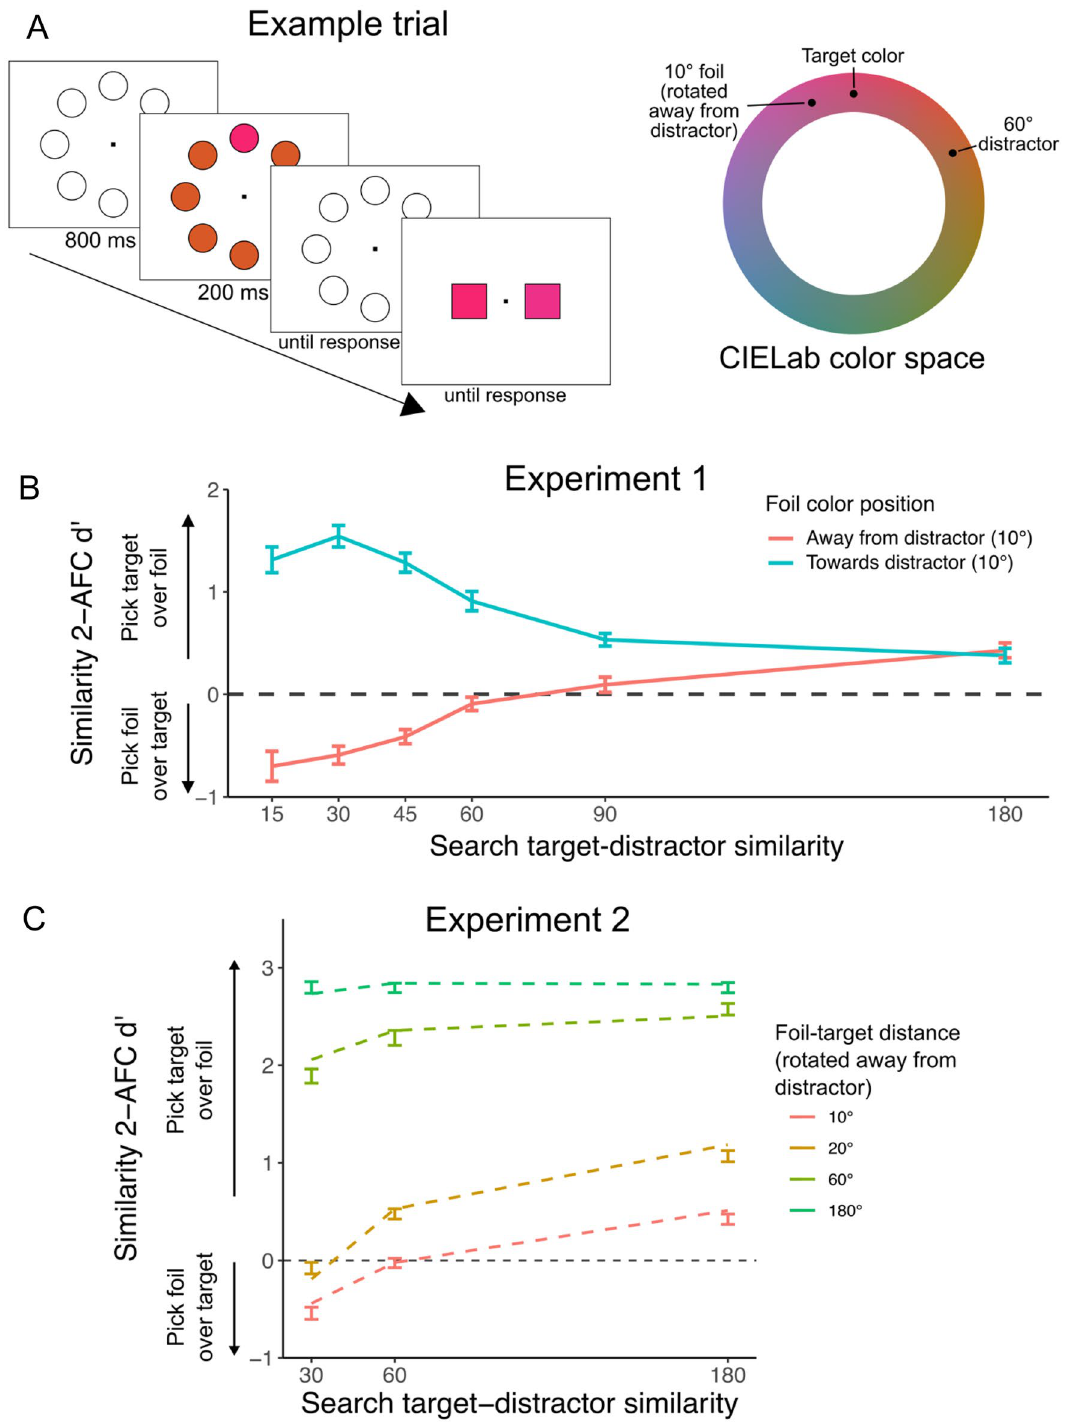
Figure 1. ( A ) Structure of an example experiment trial. Participants first searched for an oddball target item among distractors. Following report of the target’s location, they then reported which of two colors was most similar to the previous visual search target. All colors were selected from a 360° CIELab color space, and we systematically manipulated target-distractor similarity during visual search as well as the target-foil distance during the 2-AFC. Here an example is shown with a 60° color distance between target and distractor during visual search, and a foil color 10° different from the target, rotated in the direction away from the distractor color. ( B ) Results from Experiment 1. 2-AFC similarity judgment performance (d ′ ) was significantly affected by the foil color and target-distractor similarity: Participants chose the target color more often when the foil was rotated towards the distractor (positive d ′ ), but chose the foil color more often when it was rotated away for the distractor (negative d ′ ) especially for similar target-distractor conditions. ( C ) Results from Experiment 2. 2-AFC similarity judgment performance increased with less similar visual search distractors and greater foil distances. Foils were always rotated away from the distractor in this experiment. Dashed lines show fits from a signal detection model that allowed for variations in bias and strength of the target representation. Best fitting models suggested that 30° and 60° distractors resulted in a bias of 11.5° and 5.3°,